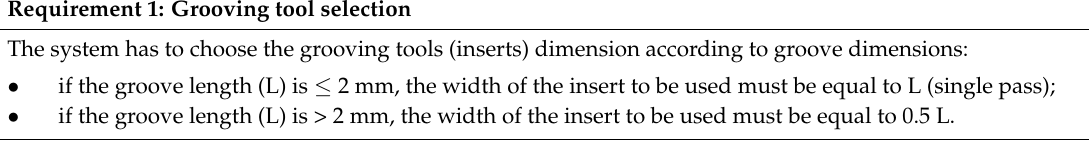
Table 1. Requirement